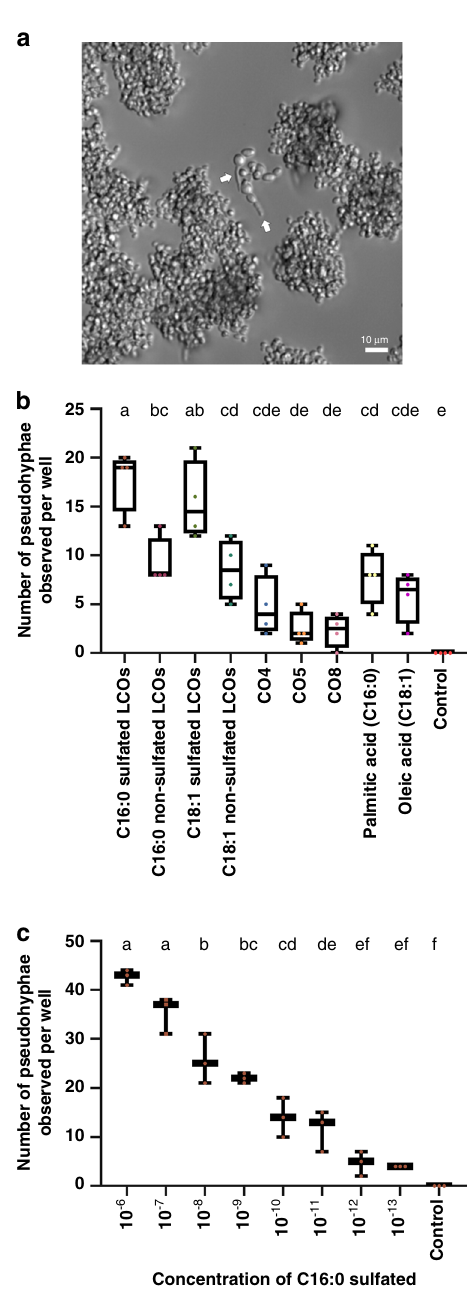
Fig. 4 Effect of LCOs, COs, and fatty acids on C. glabrata . a White arrows show pseudohyphae of C. glabrata (see also Supplementary Movies 1, 2, and 3). Scale bar is 10 µ m. b The number of pseudohyphae observed per well after treatment for 12 h with various LCOs, COs, and fatty acids at 10 − 8 M. Different letters indicate signi fi cant differences and similar letters indicate no difference according to Tukey ’ s single-step multiple comparison procedure; one-way ANOVA p -value is 9.90 × 10 − 10 . Each treatment was analyzed in four independent wells. c Effect of a range of C16:0 sulfated LCO concentrations on pseudohyphae formation; one-way ANOVA p -value is 4.67 × 10 − 12 . Different letters indicate signi fi cant differences and similar letters indicate no difference according to Tukey ’ s single-step multiple comparison procedure. Each LCO concentration was analyzed in three independent wells. In the box plots ( b , c ), the bars represent the minimum value, the fi rst quartile, the median, the third quartile, and the maximum value such that 25% of the data are in each section. Source data are provided as a Source Data fi